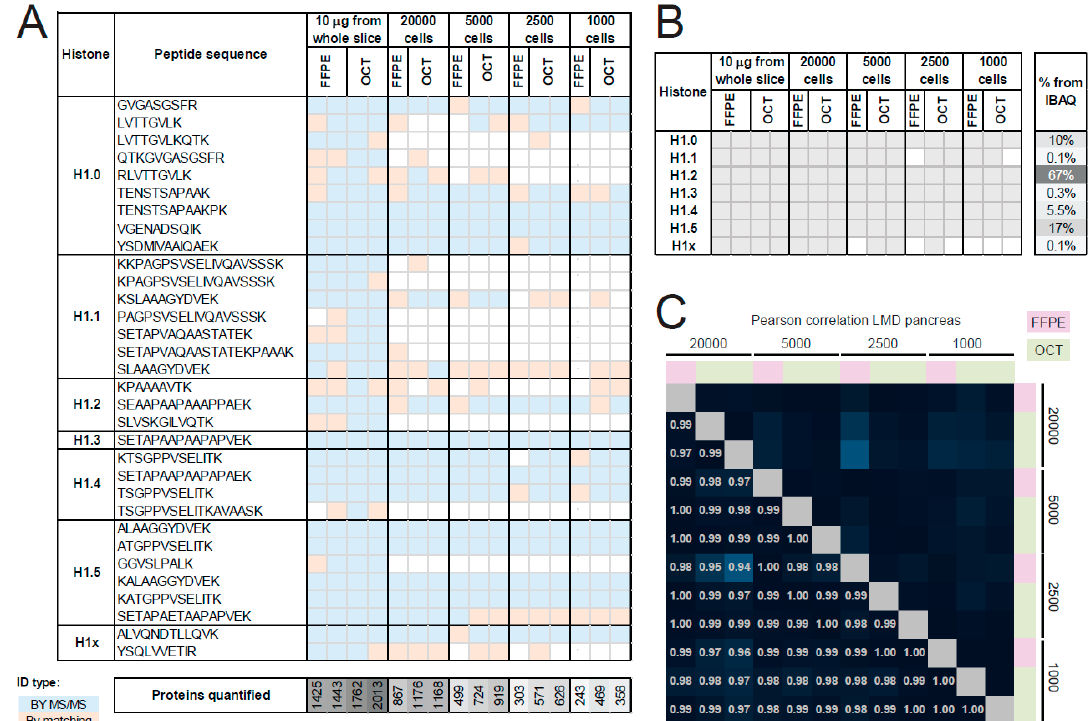
Figure 4. Quantification of histone H1 variants from laser micro-dissected samples. ( A ) Unique peptides with up to 2 miscleavages identified from mouse pancreas whole sections or laser micro-dissected areas (20,000, 5000, 2500 and 1000 cells). Peptides identified in less than three samples are not displayed. At least three samples comprising both formalin-fixed para ffi n-embedded (FFPE) and optimal cutting temperature (OCT) tissues were analyzed for each condition. White spaces indicate that the peptide was not identified and quantified. The number of proteins quantified from the same samples is also indicated. ( B ) Histone H1 variants quantified through the MaxLFQ algorithm from the samples described in ( A ). The % abundance of the di ff erent variants is indicated on the right. ( C ) Correlation matrix based on Pearson correlation coe ffi cients of log2 MaxLFQ values for histone H1 variant in the laser micro-dissected samples shown in ( A ). ID: identification.